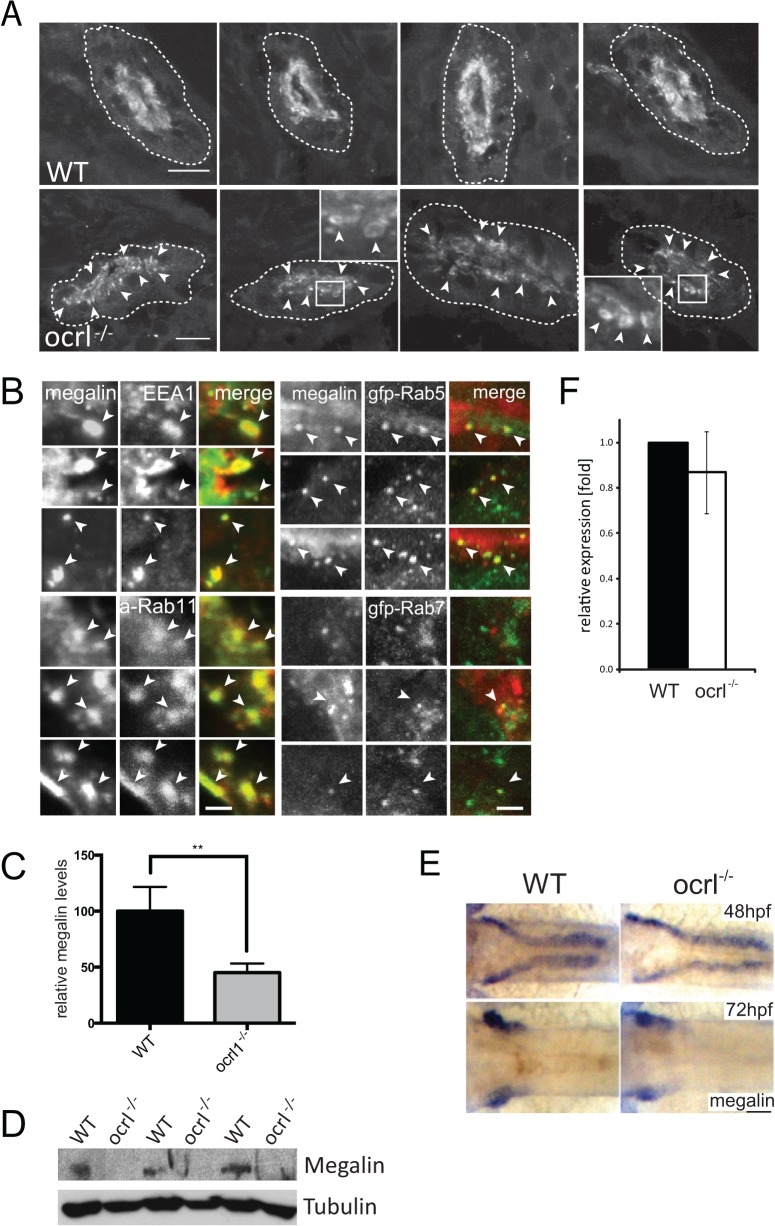
Megalin transcript and protein analysis in OCRL1-deficient zebrafish embryos.A. Transverse confocal images of the proximal pronephric region of wild-type (WT) and ocrl-/- mutant 72 hpf embryos labelled with anti-megalin antibodies. The white dashed lines indicate the outline of pronephric tubules. Arrowheads indicate sub-apical punctate and vacuolar megalin staining. B. Transverse confocal images of the proximal pronephric region of 72 hpf ocrl-/- embryos labelled with antibodies to megalin (green in left panel, red in right panel) and EEA1 (red) or GFP (gfp-, green) to detect ectopically expressed Rab5 or Rab7. mApple (a-) tagged Rab11 is in red. Arrowheads indicate colocalisation. C. Quantification of the relative fluorescence levels of megalin in confocal transverse sections of the indicated embryo types. D. Western blot of 72 hpf wild-type (WT) or ocrl-/- embryos with antibodies to megalin and tubulin. Three equivalent samples for genotype are analyzed. E. In situ hybridisation of megalin transcript in 48 hpf (top) and 72 hpf (bottom) wild-type (WT) or ocrl-/- embryos. F. Quantitative RT-PCR (qPCR) of megalin transcript levels in wild type and ocrl-/- embryos at 72 hpf. Data are presented as the mean ± SD. Statistical analysis was performed using the unpaired t-test. ***p < 0.0001. Scale bars in A, B and E represent 10, 2 and 20 μm respectively.